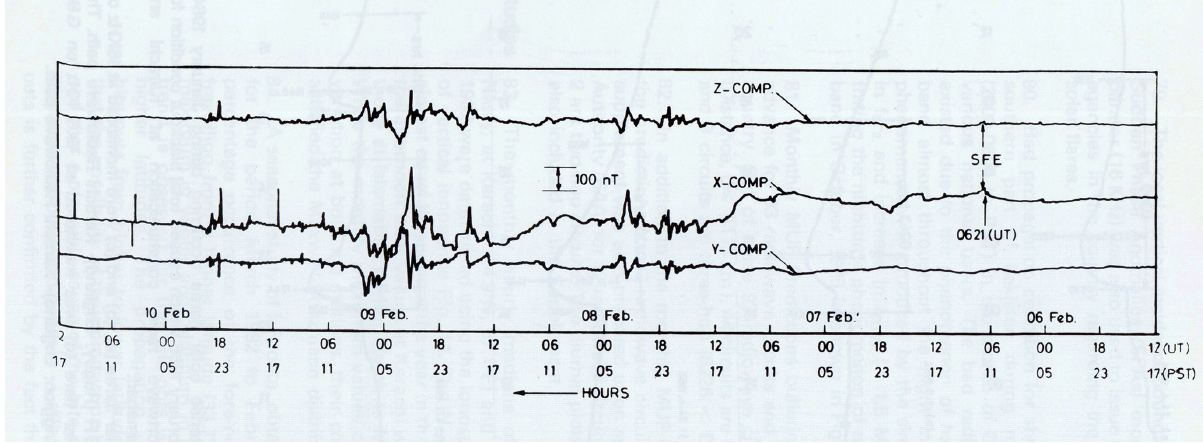
Figure 4. This figure shows a magnetic storm due to a solar flare effect (SFE) recorded by AMOS-III in February 1986. (Image credits: SUPARCO, 1986; available at SUPARCO library.)